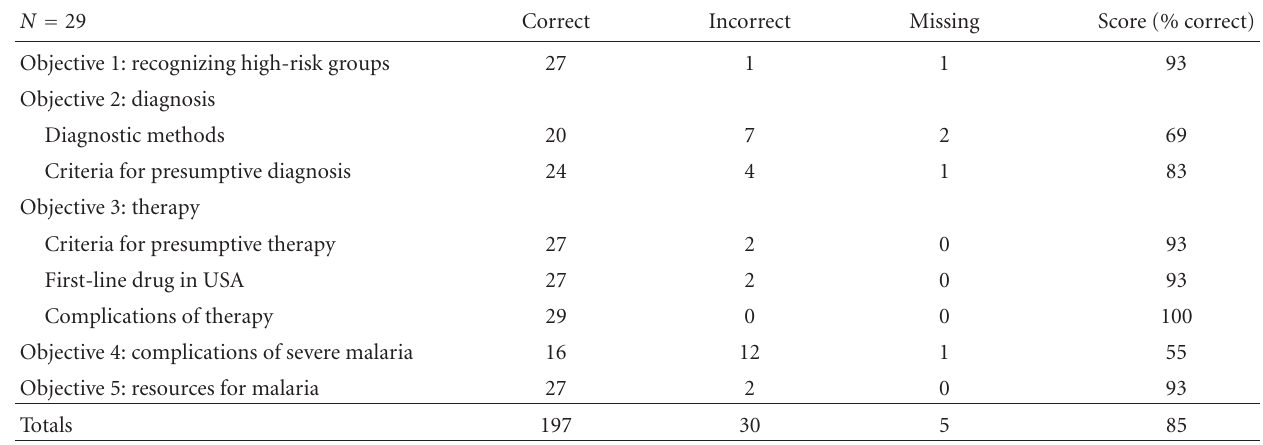
Table 3: Postscenario test